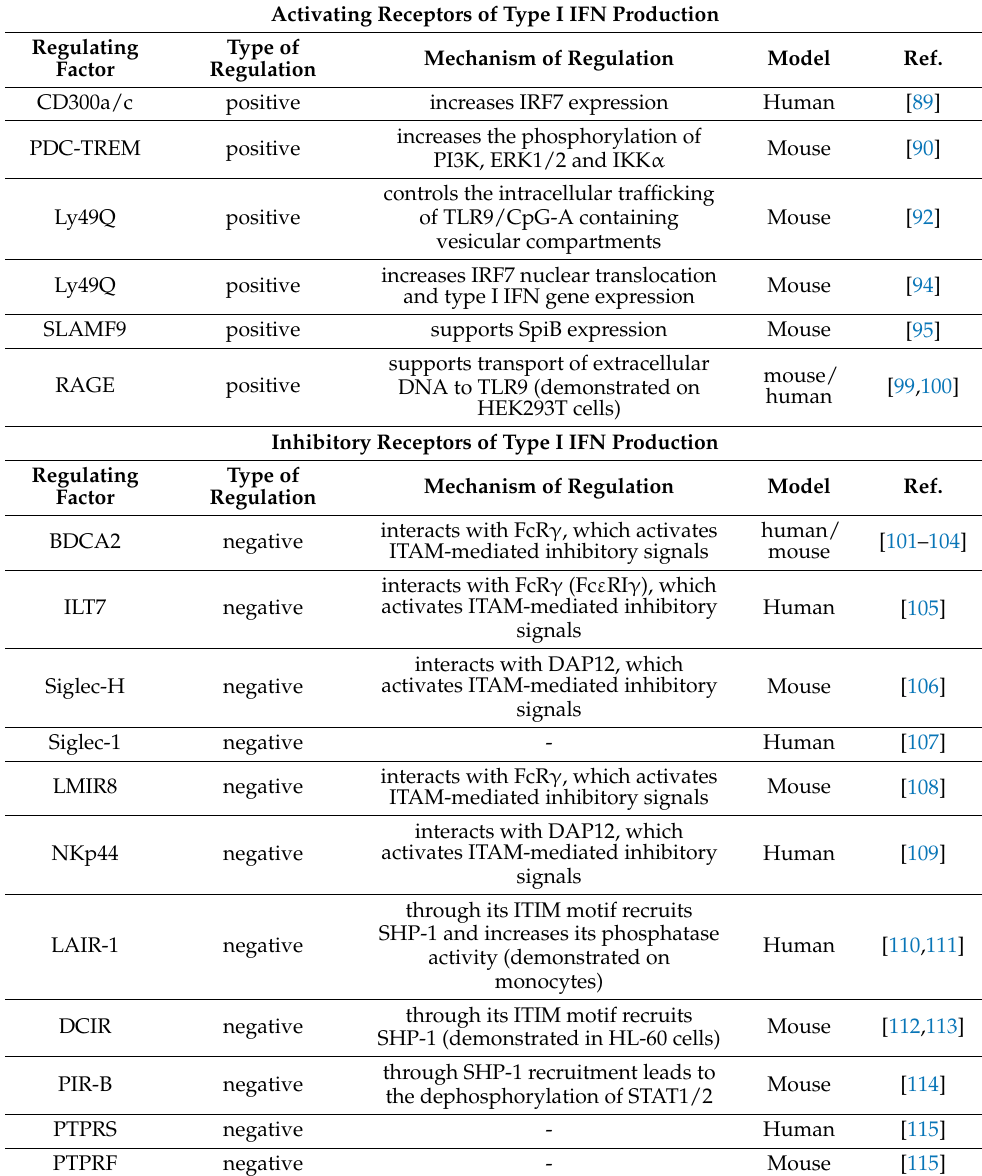
Table 2. Regulation of type I IFN production by receptor